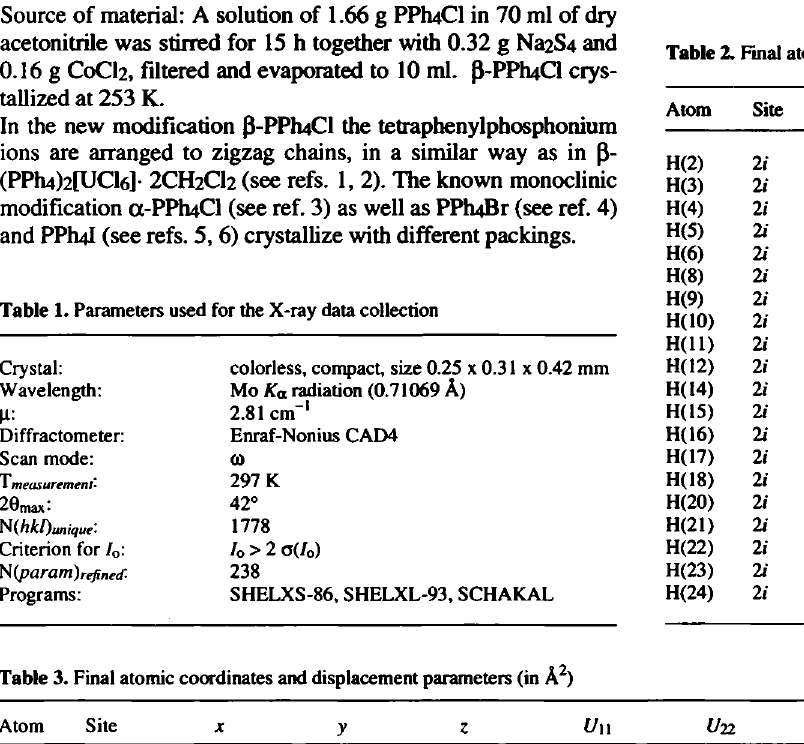
Table 2. Fmal atomic coordinates and displacement parameters (in